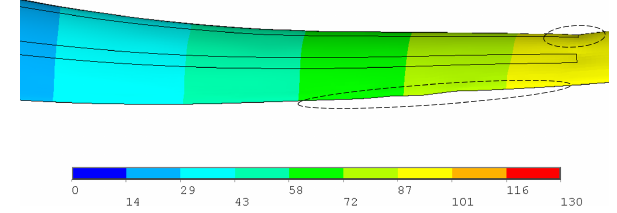
Figure 26. Total deformation occurring in the form of local defor- mation due to failed elements at 118% extreme combined edge- wise and extreme flapwise loading. (Scale factor for deformation plot: ×